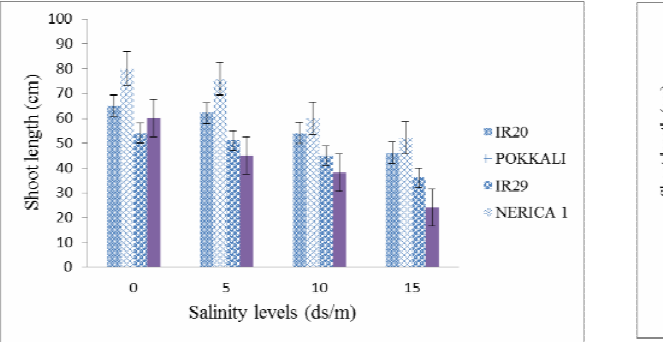
Fig. 1. Effect of salinity on shoot length (cm) of different rice varieties